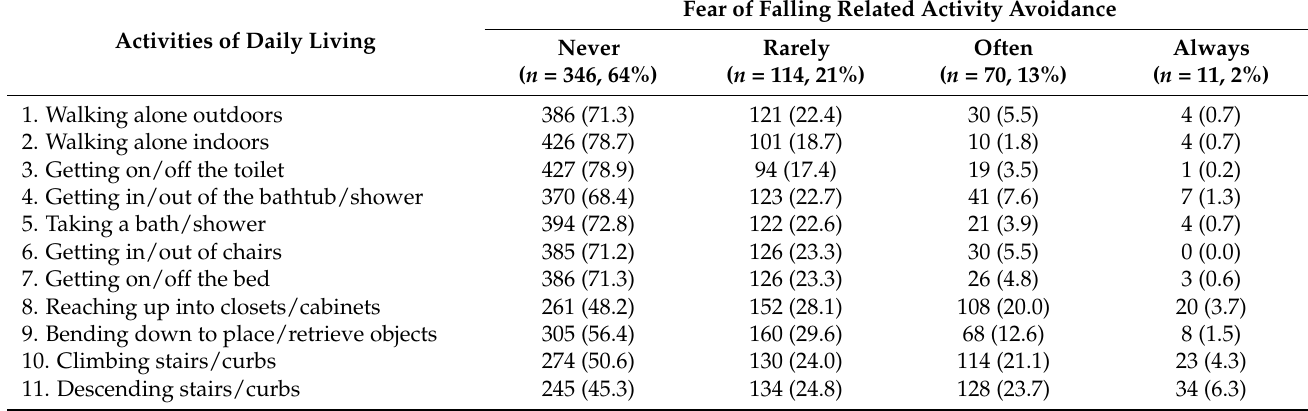
Table 1. Distribution of fear-related activity avoidance ( N =